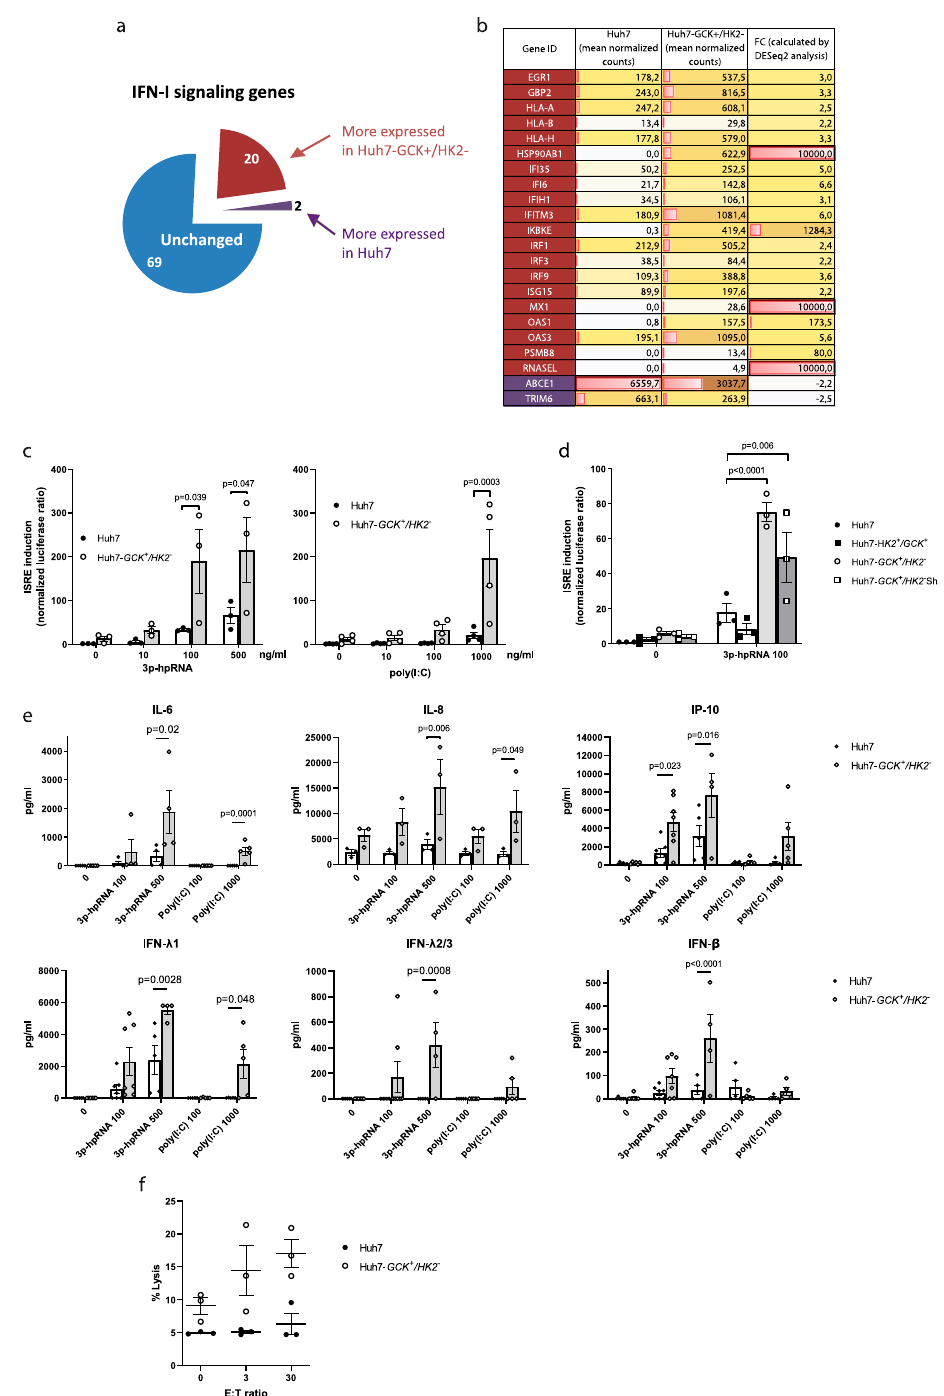
Fig. 6 Innate immune response is enhanced in Huh7- GCK + /HK2 − cells. a Sector chart from the transcriptomic study showing genes included in the GO- term “ Type I-IFN signaling pathway ” . b List of genes signi fi cantly up-regulated in red or down-regulated in purple (| FC | > 2, BH adjusted p value<0.05) in Huh7- GCK + /HK2 − compared to Huh7 cells ( n = 3). c – e Cells were stimulated or not for 48 h with 3p-hpRNA (RIG-I ligand) or poly(I:C) (IFIH1/MDA5 ligand). ISRE-luciferase expression was monitored and normalized to Renilla luciferase ( c , d ) ( n = 3 for 3p-hpRNA and n = 4 for poly(I:C) treatments). Cell supernatants were assayed for cytokine concentration by multiplex assays ( n = 3 to 7) ( e ). f NK cell mediated lysis of Huh7 or Huh7- GCK + /HK2 − cells. Hepatoma cells were seeded 24 h before NK cells addition for 4 h at effector to target (E:T) ratio of 0, 3 or 30. After harvesting, cell lysis was determined by the percentage of PI + cells on gated hepatocytes ( n = 3). Means ± SEM of indicated n independent experiments are presented and p values were obtained from 2-way ANOVA analyses comparing matched cell means with Sidak ’ s correction for multiple comparison, with α = 0.05.